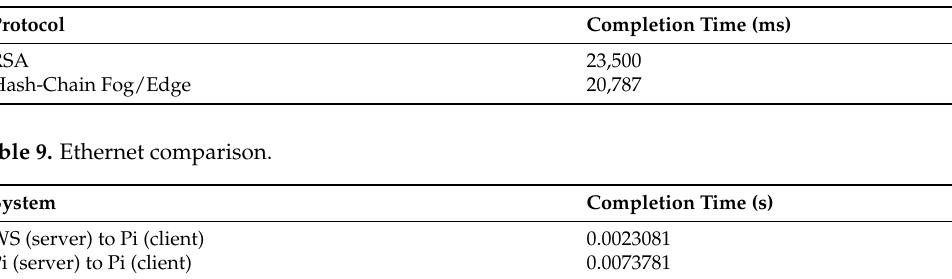
Table 8. Comparison of standard benchmarks.